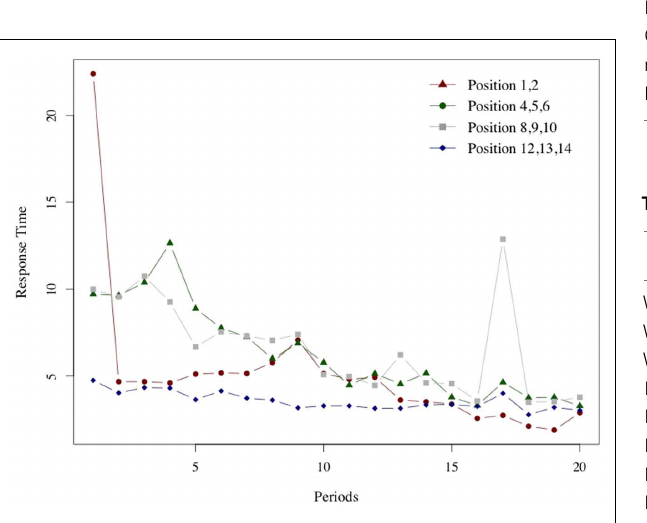
FIGURE 7 | Response times in winning positions. As in the previous Figure 6 we report for each of the 20 periods in which the game G (15, 3) was played the average response time at each of the four winning positions groups.